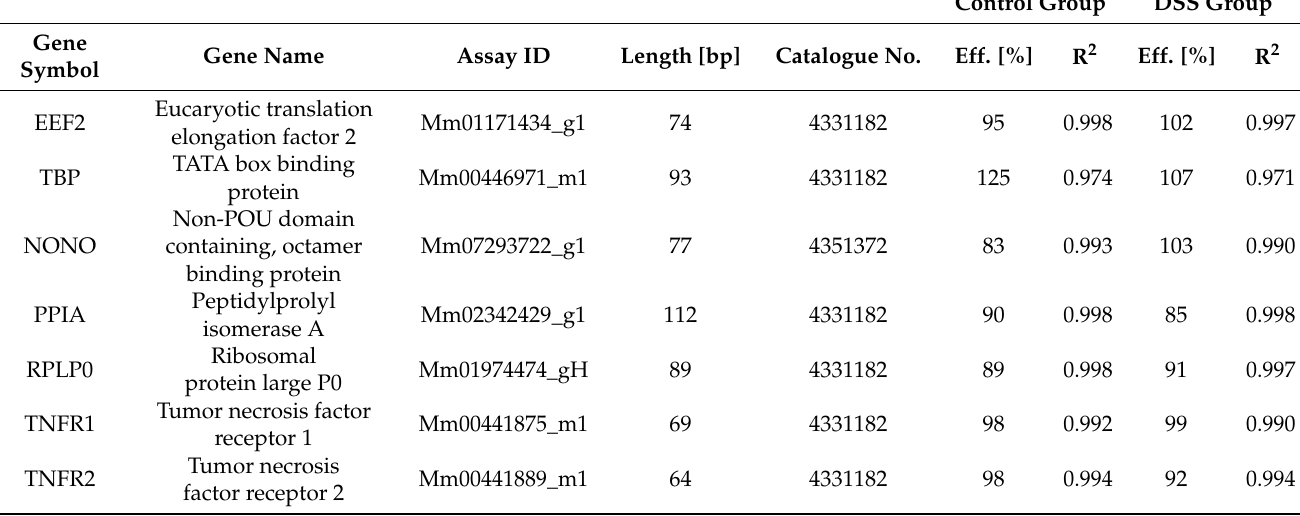
Table 1. Information on mRNA candidate reference genes and target genes and their qPCR amplifi- cation characteristics in archived FFPE colon samples of control and DSS-treated C57BL6/JOlaHsd mice. Legend: Eff., amplification efficiency; R2, correlation